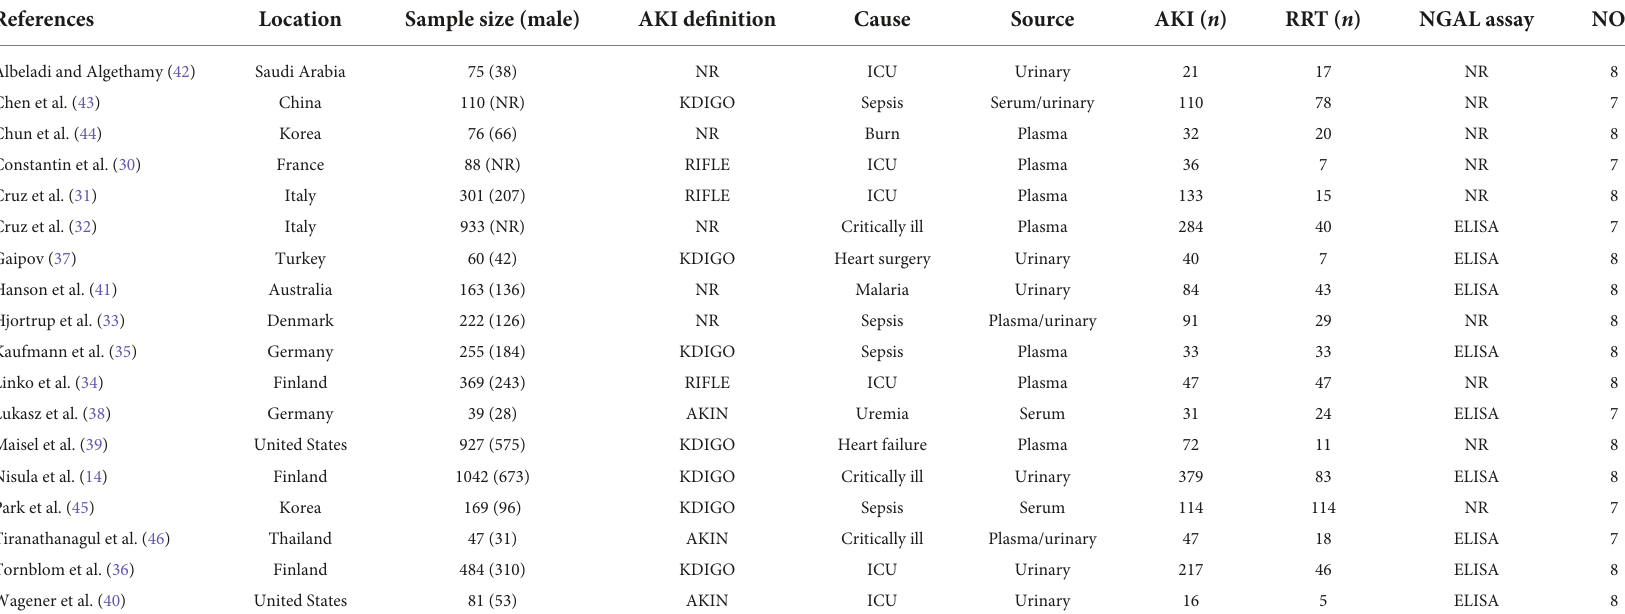
TABLE 1 Main characteristics of the studies included in the